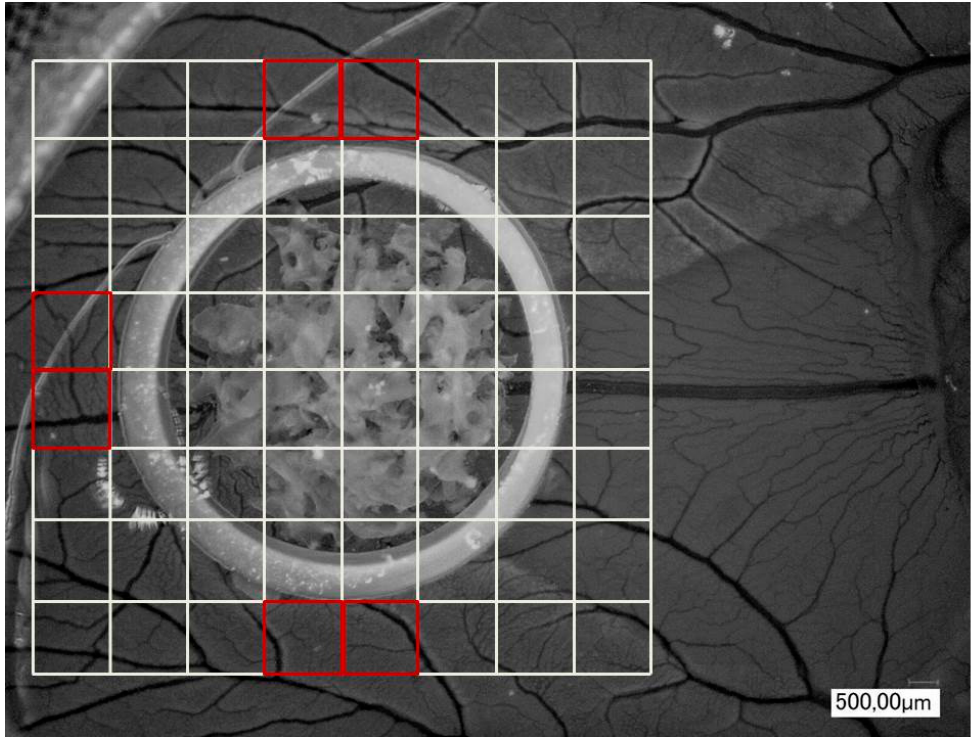
Figure 1. Exemplary picture (30 × magnification) of an incubated bone substitute materials (BSMs) in the chorioallantoic membrane (CAM) assay with the six defined regions of interest per mm 2 around the ring.